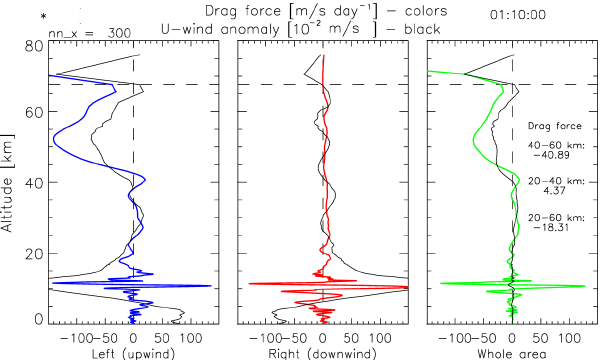
Figure 4. Spatial average of drag force (ms − 1 day − 1 ) on the left side (blue), right side (red) and whole domain (green), within a ra- dius of 300km from storm centre, at t = 70min of integration time. Vertically averaged values of mean drag force for the whole area are reported in figure, in ms − 1 day − 1 . Zonal (thin black line) wind speed anomaly (10 − 3 ms − 1 ) is also